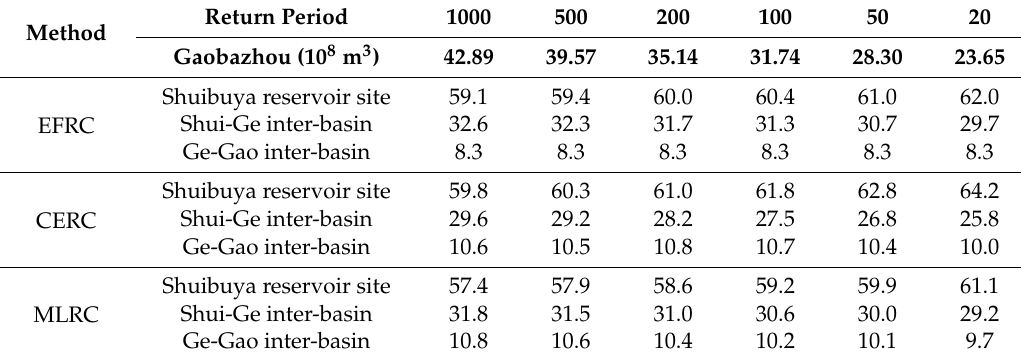
Table 6. Proportion of 3-day flood volume in each region at Gaobazhou reservoir site